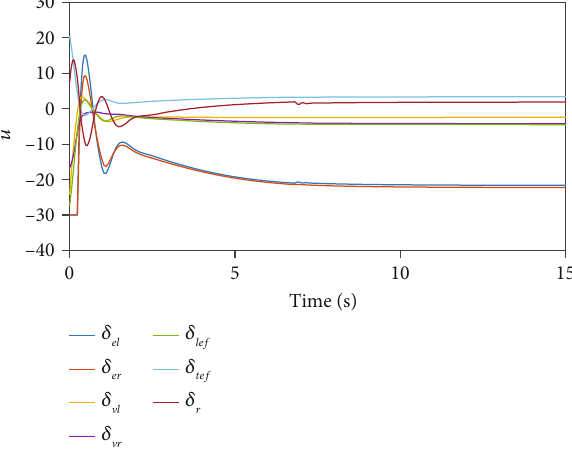
Figure 13: The responses of actuator of fi ghter